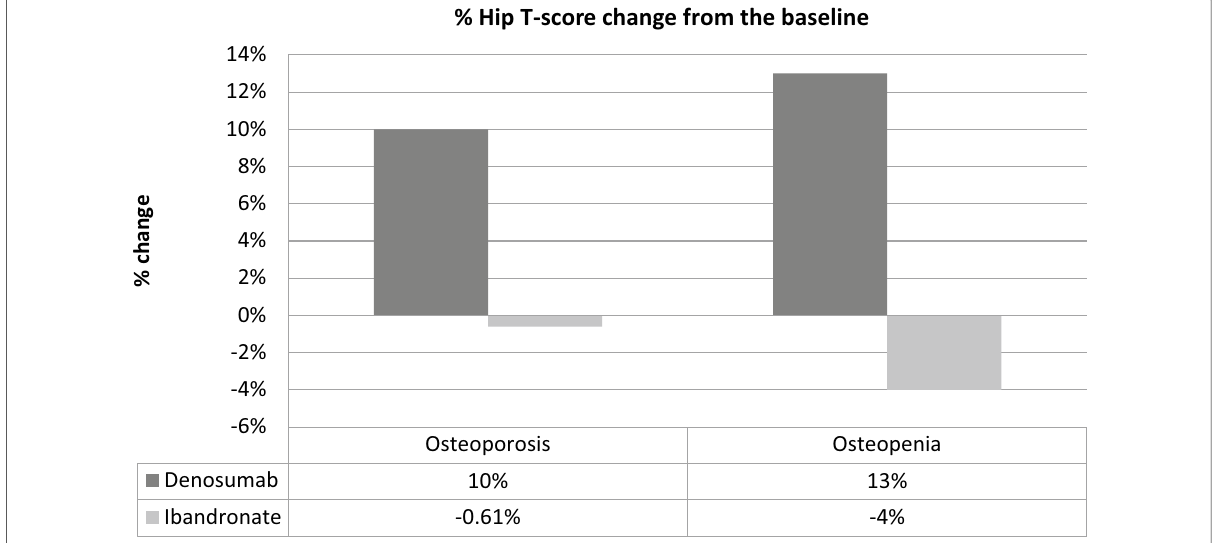
The data shows the percentage change in the hip T-score from the baseline after one year of treatment Fig. 2 Percentage hip T‑score change from the